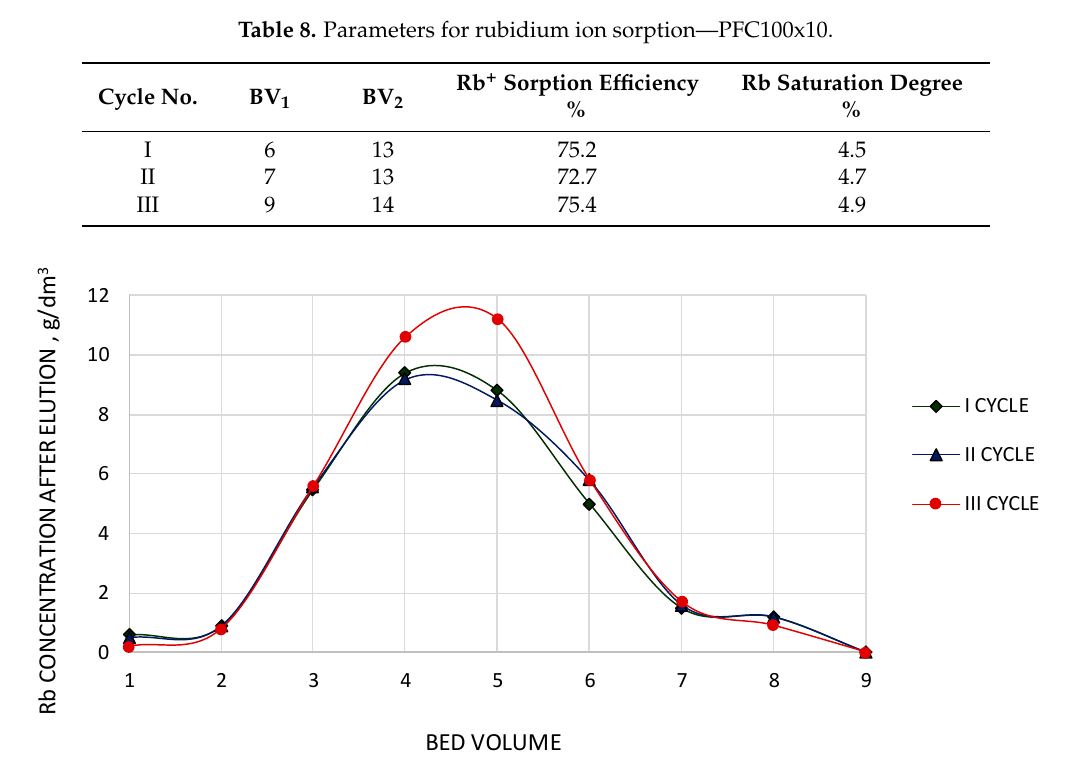
Figure 4. Characteristics of PFC100x10 during elution. Table 8. Parameters for rubidium ion sorption—PFC100x10. Table 9. Parameters for rubidium ion elution—PFC100x10.